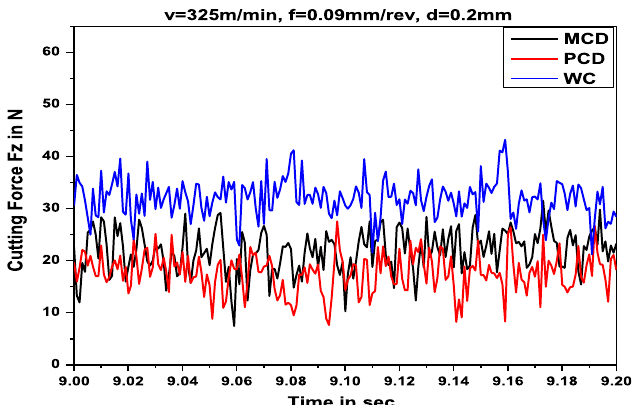
Fig. 11. Dynamic component of cutting force vs. time graph at v = 325m/min, f =0.09 mm/rev, d = 0.2mm.